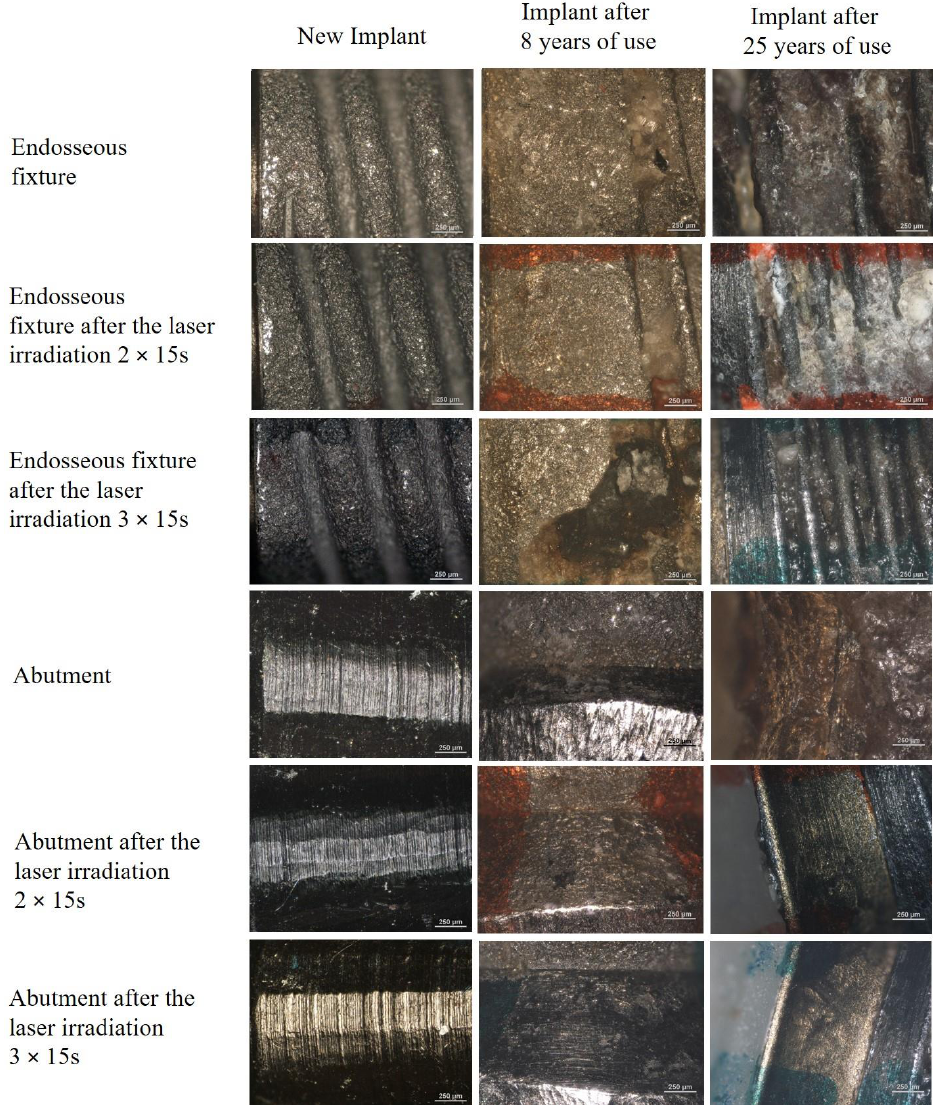
Figure 4. Reflected light microscopic images of the surfaces of the implants: (1750 × 1300 μm) new, removed after 8 and 25 years before and after the laser irradiation 25 W/15.000 Hz/10 μs, average = 3.84 W, during irradiation 2 × 15 s and 3 × 15 s.